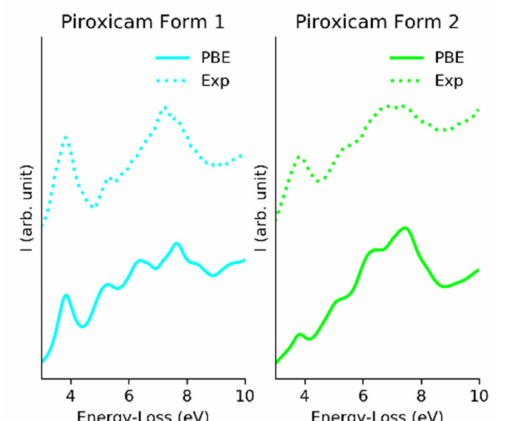
Figure 5. Comparison between calculated EELS spectra (solid line) and experimental EELS data (dotted line), for phases form 1 and form 2.